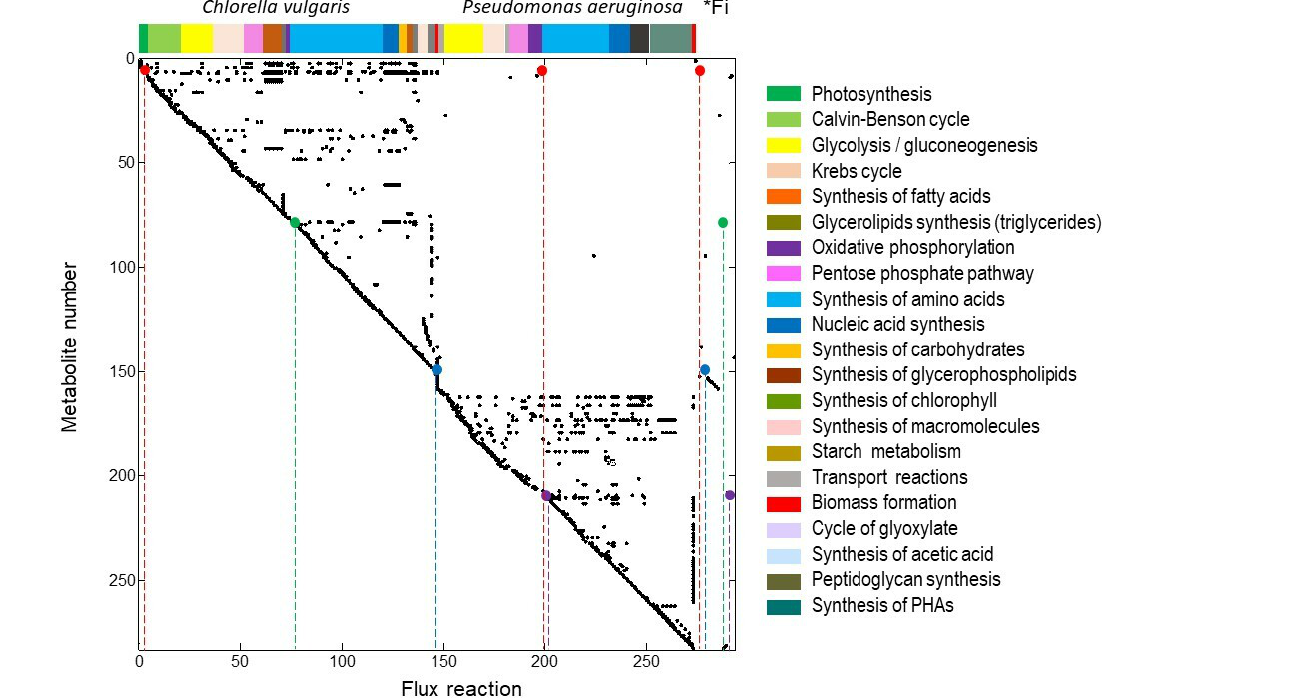
Figure 1. Estequiometric matrix S , of co-culture of C. vulgaris and P. aeruginosa . Main metabolisms